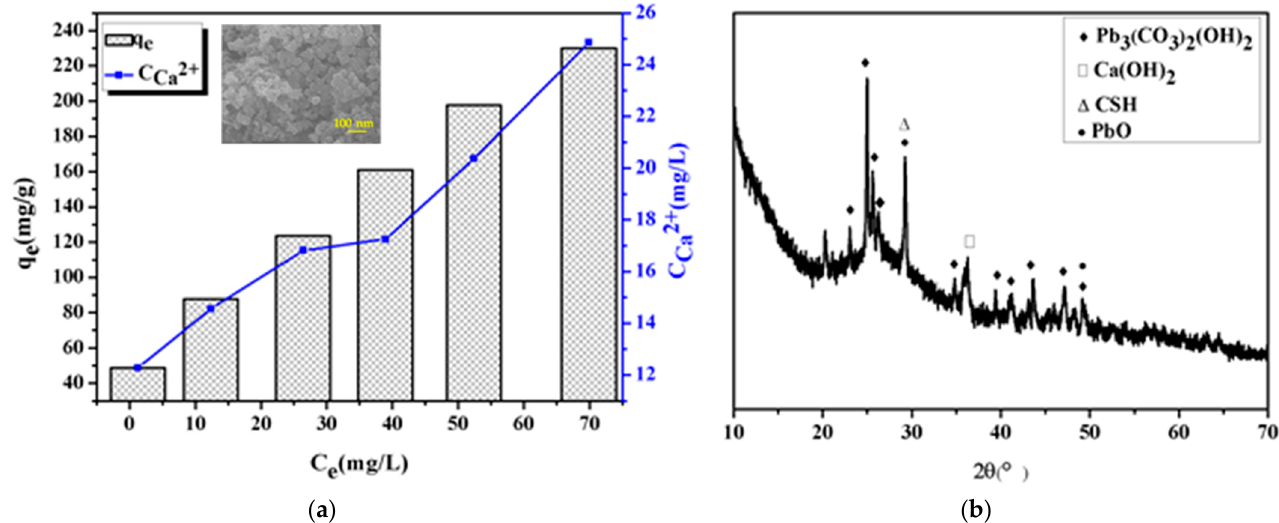
Figure 7. ( a ) Relationship between adsorption amount and Ca 2+ concentration in solution and SEM image of CSH after Pb(II) adsorption (inset), ( b ) XRD pattern of CSH after Pb(II) adsorption.